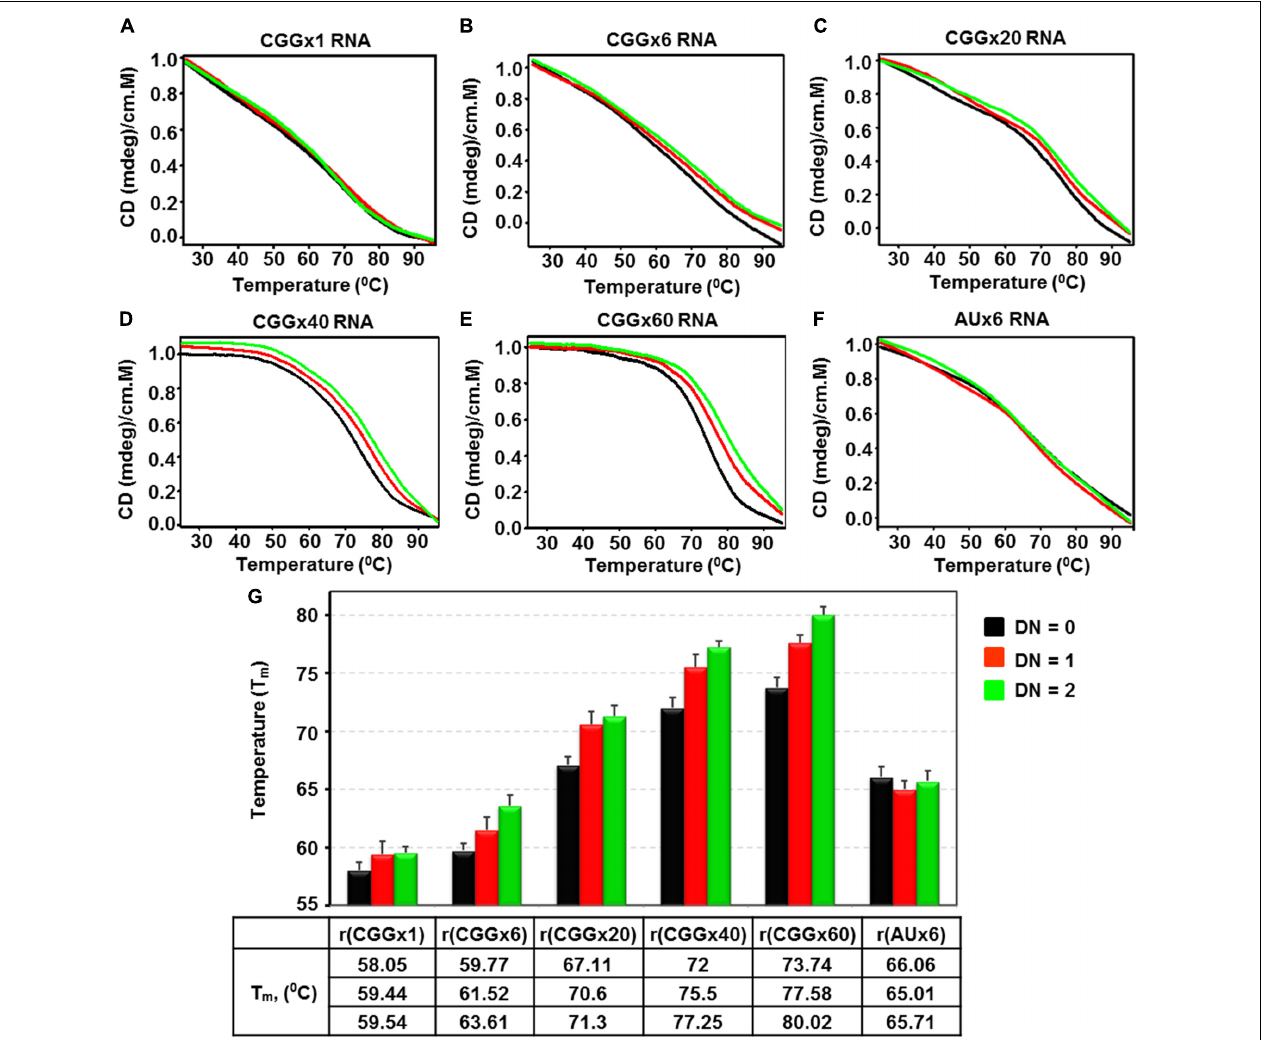
FIGURE 4 | Diagram represents CD melting titration of r(CGG)n repeats containing RNAs and r(AU) fully paired RNA as a function of Curcumin concentration. Diagram shows titration plot of (A) r(CGGx1), (B) r(CGGx6), (C) r(CGGx20), (D) r(CGGx40), (E) r(CGGx60) and (F) r(AUx6) duplex RNA with increasing concentration of Curcumin. (G) Bar graph represents the melting temperature (T m ) values of respective RNA at different drug by nucleotide ratio (D/N). All the melting titrations were repeated three times and the average values are